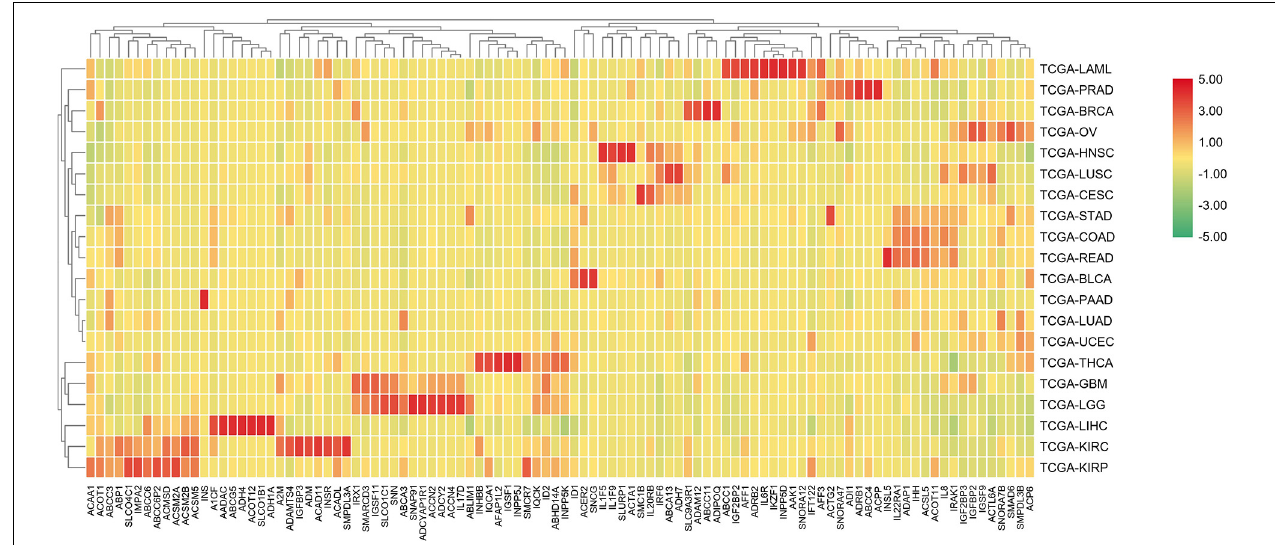
FIGURE 5 | A heat map of the first 100 genes was screened by the random forest algorithm. Where, row is cancer type, column is gene. In this part, RPKM is used to define the gene expression level, and the average value of samples in each cancer type is calculated as the gene expression difference.